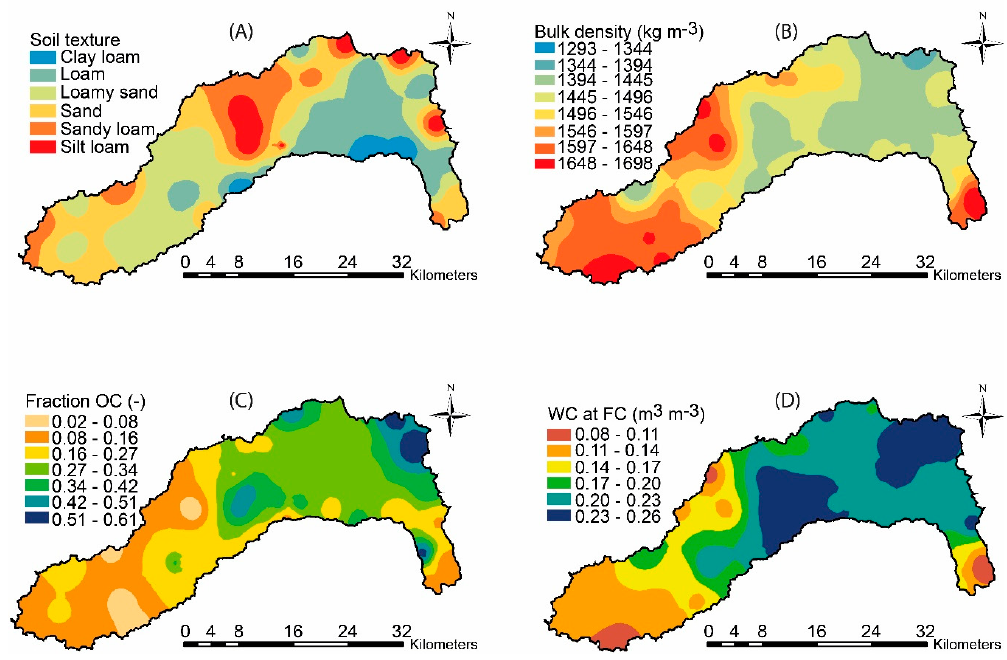
Figure 2. Spatial variability in soil texture ( A ), bulk density ( B ), fraction organic carbon ( C ), and water content at field capacity ( D ) in Jazan watershed. content at field capacity ( D ) in Jazan